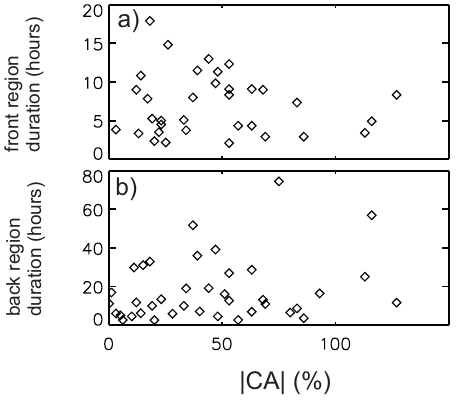
Fig. 4. Top: Duration of the MC (a) front and (b) rear regions as a function of the relative closest approach distance | CA | (from the Wind